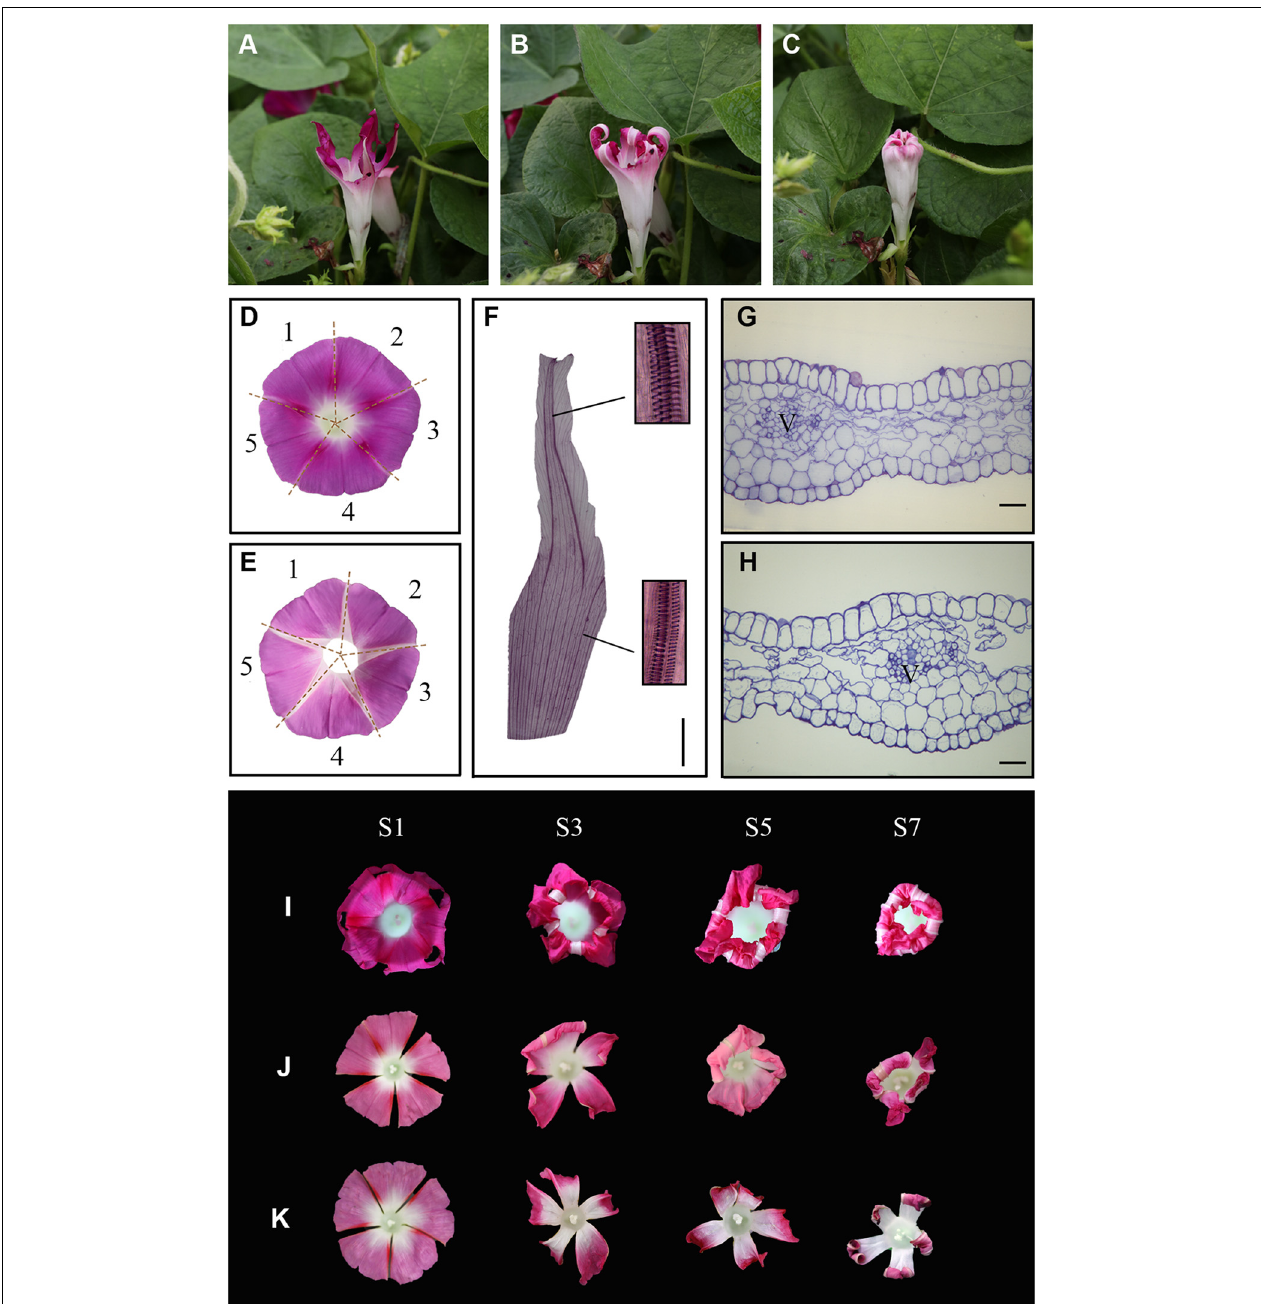
FIGURE 2 | The acuminate veins maintain a trumpet shape to ensure corolla closure. (A–C) An insect-eaten corolla remains closed under natural conditions. (D,E) The white acuminate structures are arranged in the shape of a pentagram, and the sympetalous corolla consists of five parts. (D,E) show the adaxial and abaxial sides, respectively. (F) Structural observation of acuminate veins in transparent tissue. Magnified views of spiral vessels are shown in black boxes. Scale bar = 0.5 cm. (G,H) Transverse semi-thin sections of acuminate veins during the corolla opening (G) and closure (H) stages. V = vascular bundle. Scale bars = 50 µ m. (I–K) The process of corolla closure was observed after the artificial destruction of acuminate veins. (I) 1/3 of the acuminate vein structure was removed. (J,K) Four or five acuminate veins were artificially destructed, respectively.